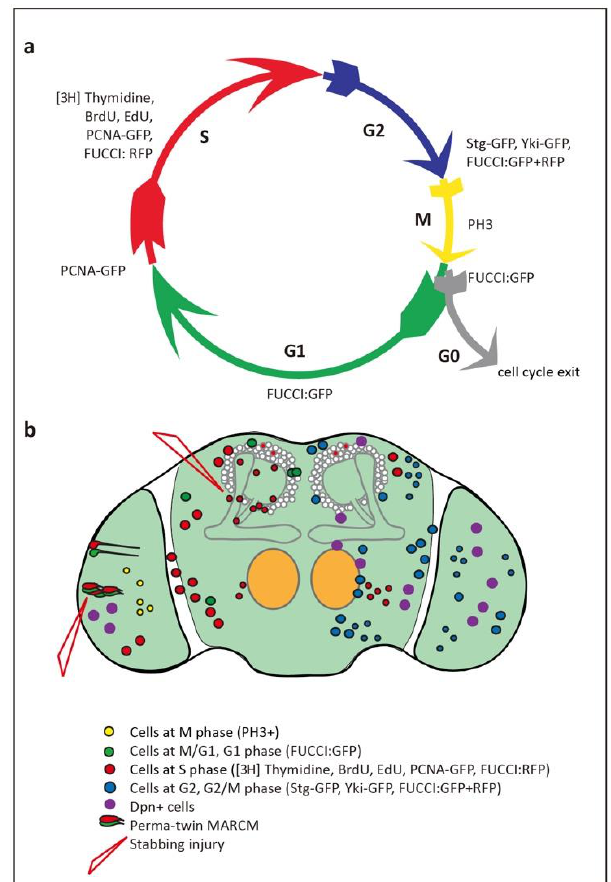
Figure 2. Evidence of glio- and neuro-genesis in the adult Drosophila brain. ( a ) Cell cycle phases and markers used to visualize them. ( b ) Summary of findings, indicating cells reported in each of the cell cycle phases in the adult brain, including in optic lobes, antennal lobes, sub-aesophageal ganglion and central brain.